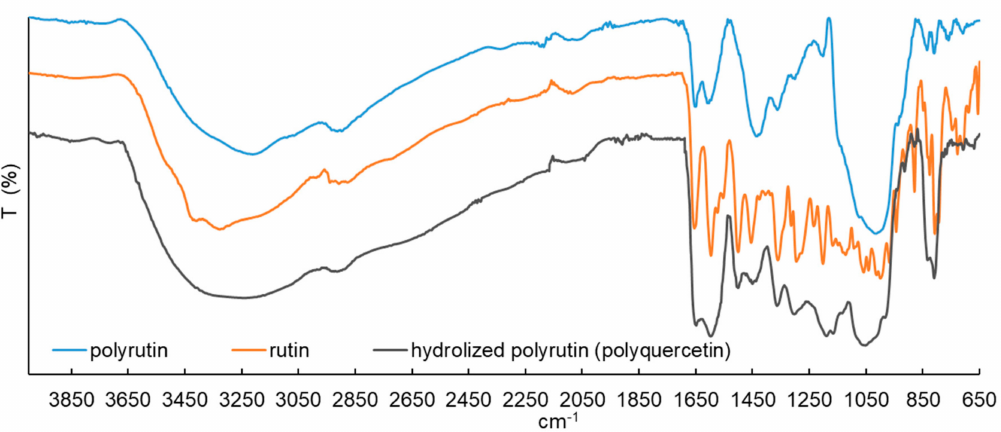
Figure 2. ATR-FTIR spectra of PR ( top ), RU ( centre ), and PQ ( bottom